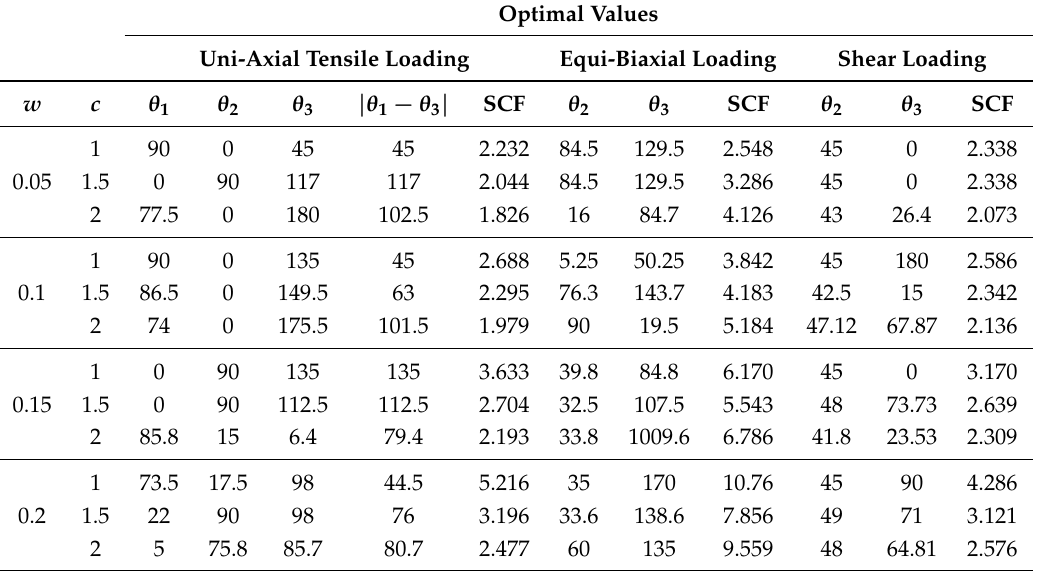
Table 8. The optimal values of design variables in different values of bluntness w and aspect ratio of rectangular cutout c